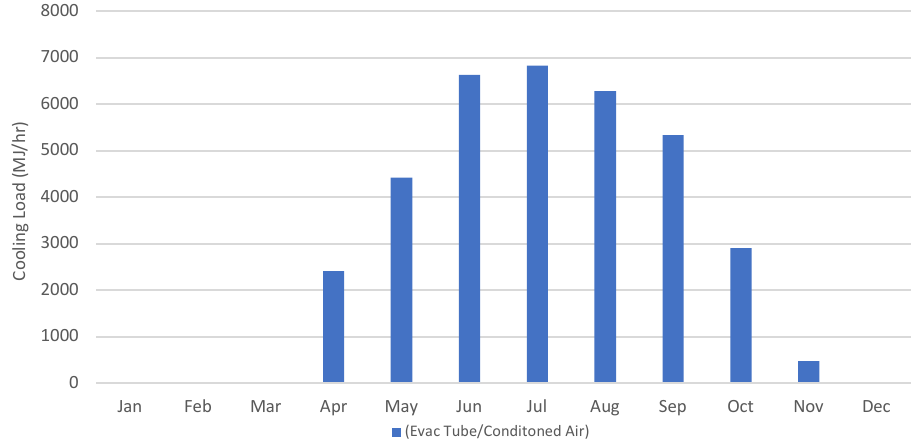
Figure 6. Monthly cooling loads for the selected commercial building situated in Kuwait.